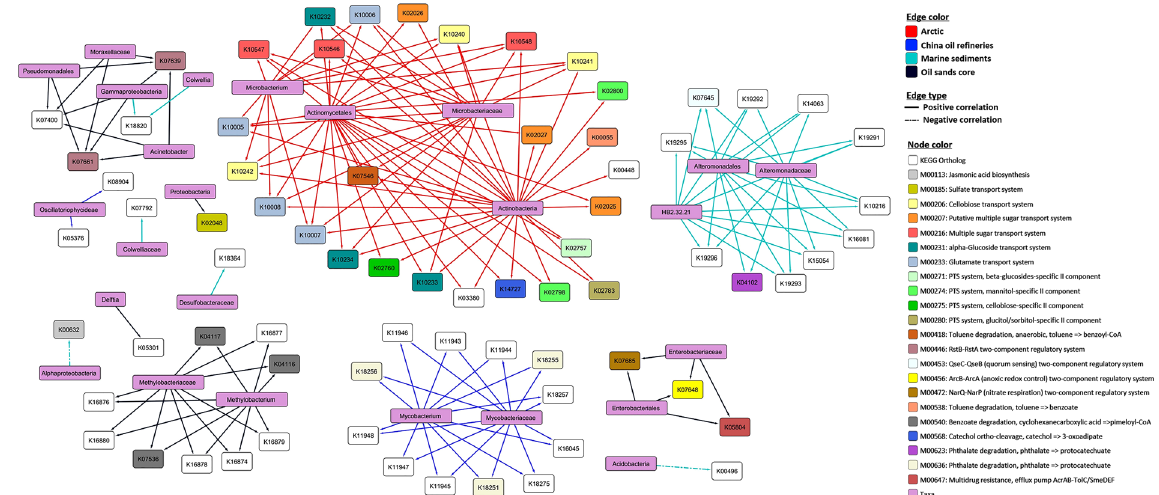
Figure 4. Subset of significant correlations exhibited between KEGG orthologous gene families and bacterial clade abundances. Spearman correlations were calculated between KEGG orthologous gene families and phylotypes at any taxonomic level from phylum to OTU within 4 oil polluted habitats (habitats with six or more samples). A subset of significant associations with correlation > 0.7 and p-value < 0.001 reaching a Benjamini- Hochberg false discovery rate < 0.01 are shown here. Taxonomic clades are represented in rectangles with a light purple background and KEGG orthologs are depicted in rectangles with white background (see legend). KEGG orthologs are colored according to corresponding KEGG modules, wherever applicable (see legend). Correlations for each habitat is depicted using different colors (red, Arctic; blue, China oil refineries; turquoise, Marine sediments; midnight blue, Oil sands core) with positive and negative associations represented by continuous and broken arrow lines respectively (see